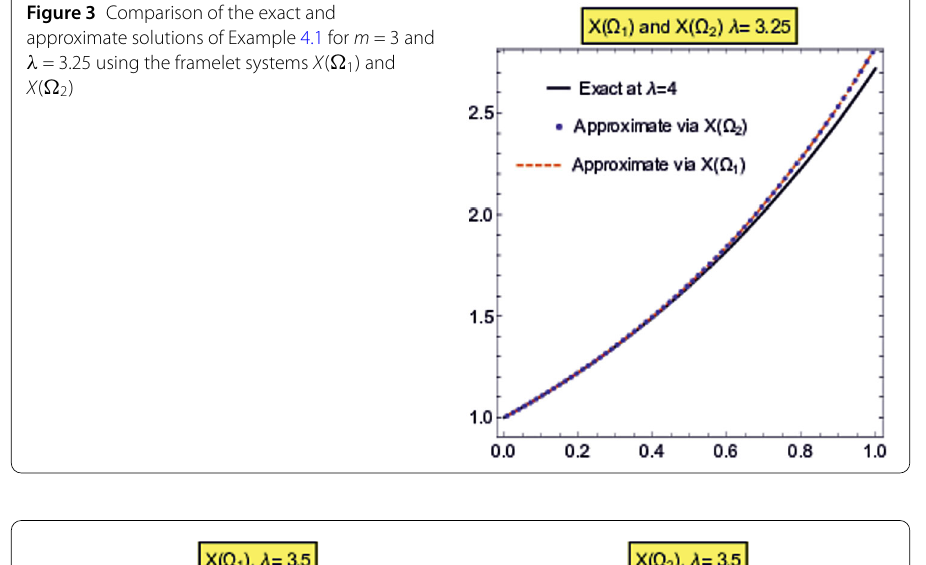
Figure 3 Comparison of the exact and approximate solutions of Example 4.1 for m = 3 and λ = 3.25 using the framelet systems X ( (cid:7) 1 ) and X ( (cid:7) 2 )